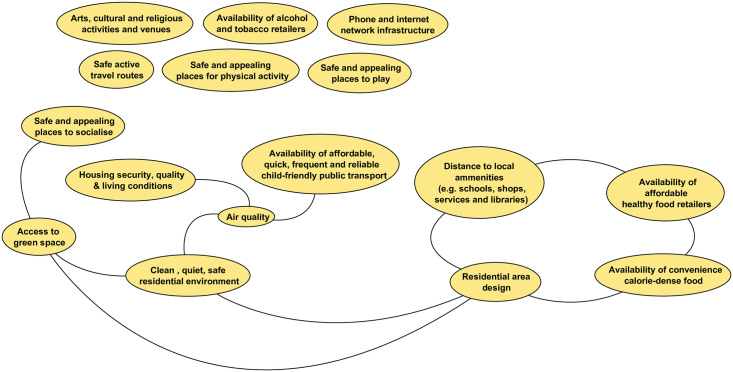
The physical domain.